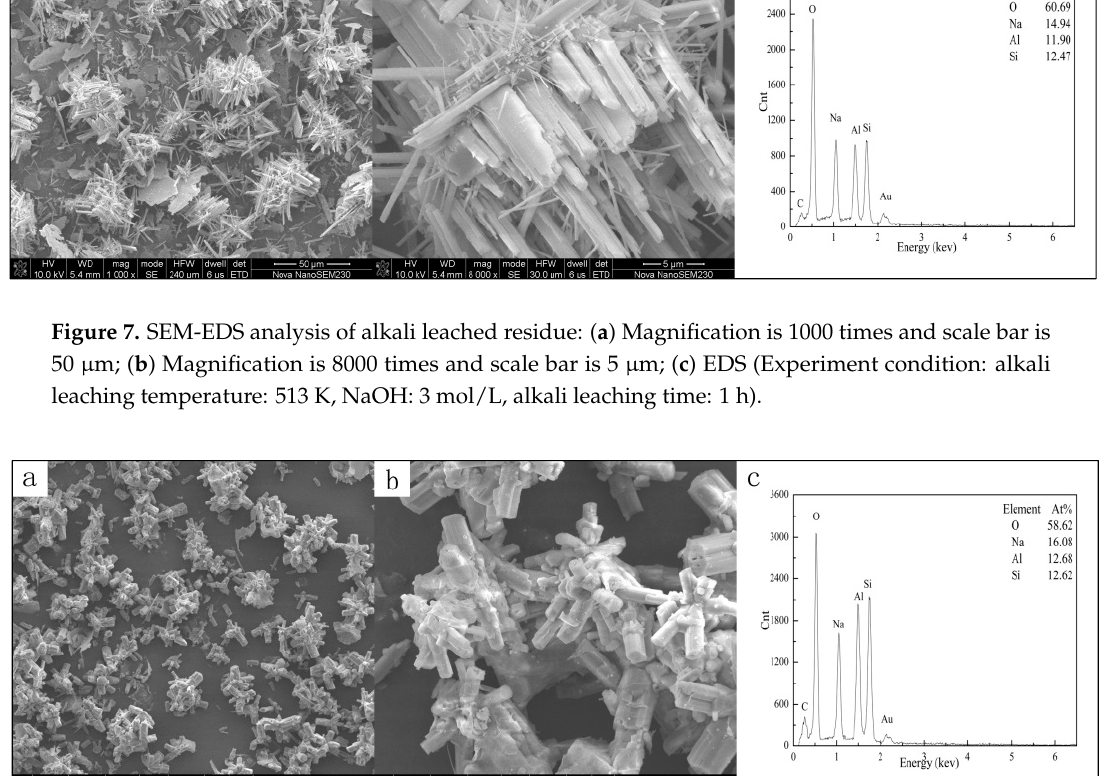
Figure 8. SEM-EDS analysis of alkali leached residue: ( a ) Magnification is 1000 times and scale bar is 50 μ m; ( b ) Magnification is 5000 times and scale bar is 10 μ m; ( c ) EDS (Experiment condition: alkali